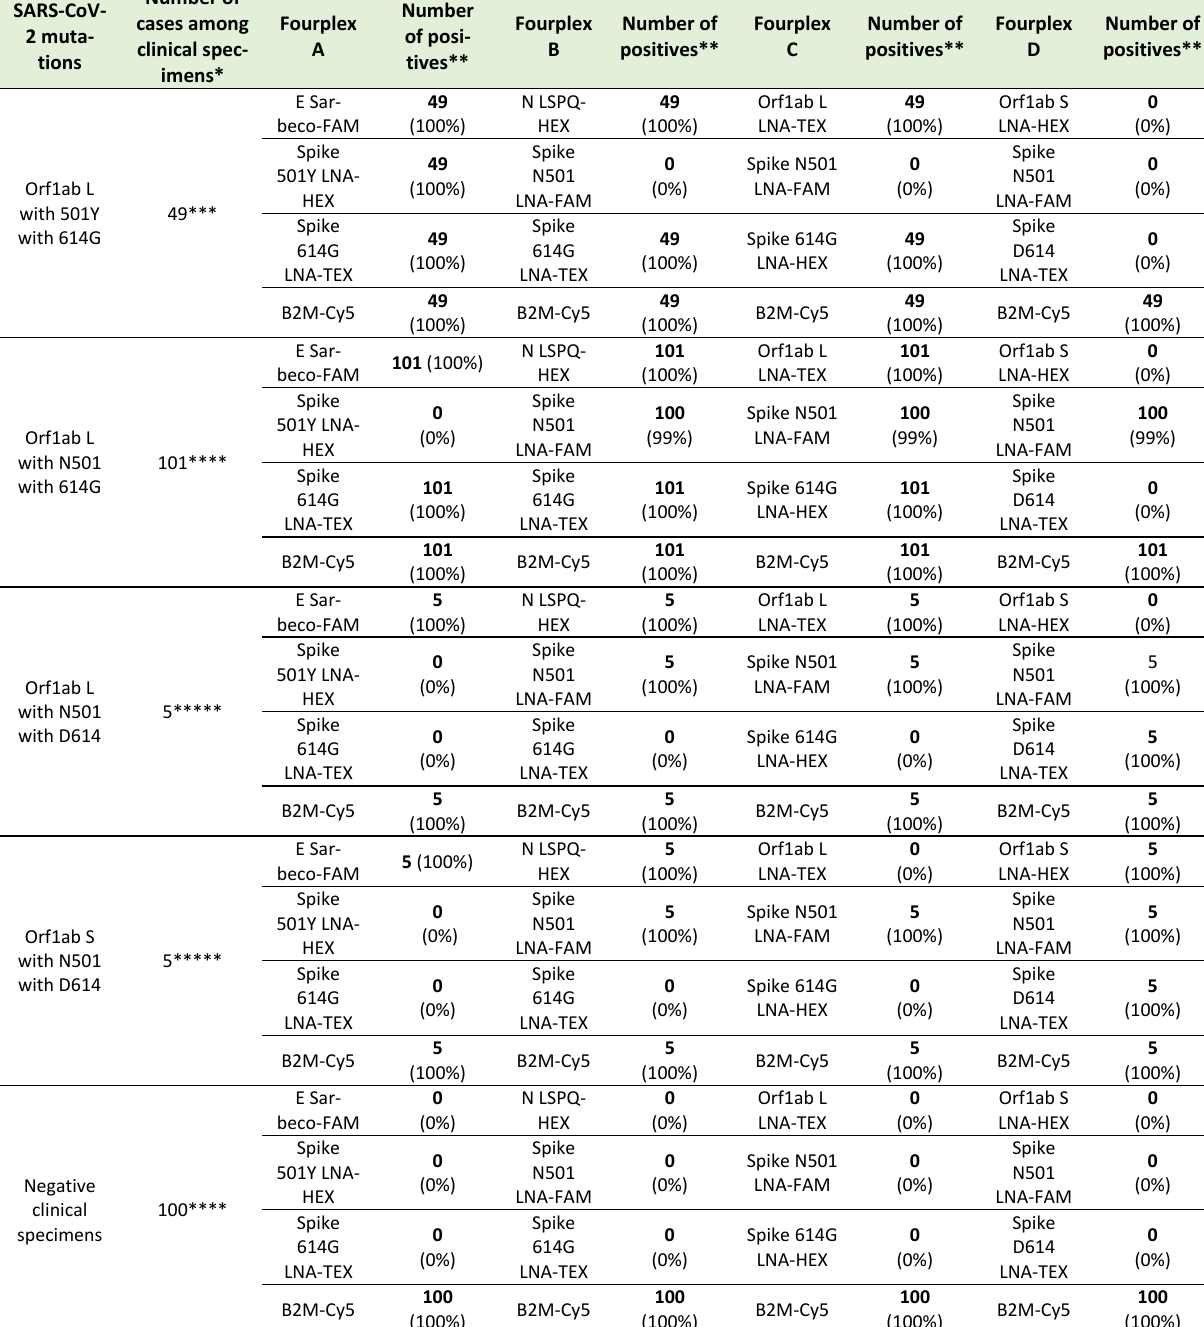
TABLE 6. Test results using fourplex sets of primers/probes for the detection of SARS-CoV-2 variants in clinical